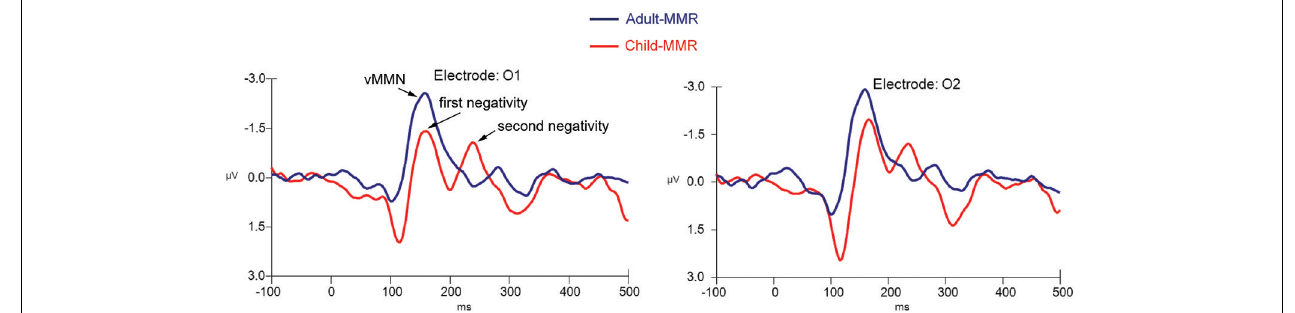
FIGURE 9 | Difference wave computed by subtracting standard non-target from deviant non-target ERPs for both children ( N = 21) and adults ( N = 20) at electrode positions F3, Fz, F4, C3, Cz, C4, P3, Pz, and P4.